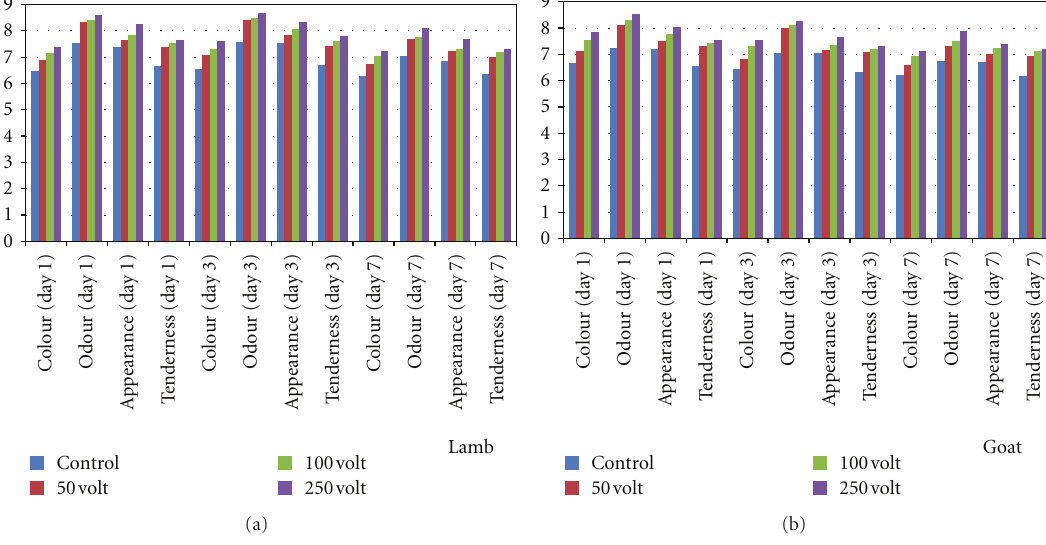
Figure 2: Sensory evaluation of lamb and goat meat during aging at 4 ◦